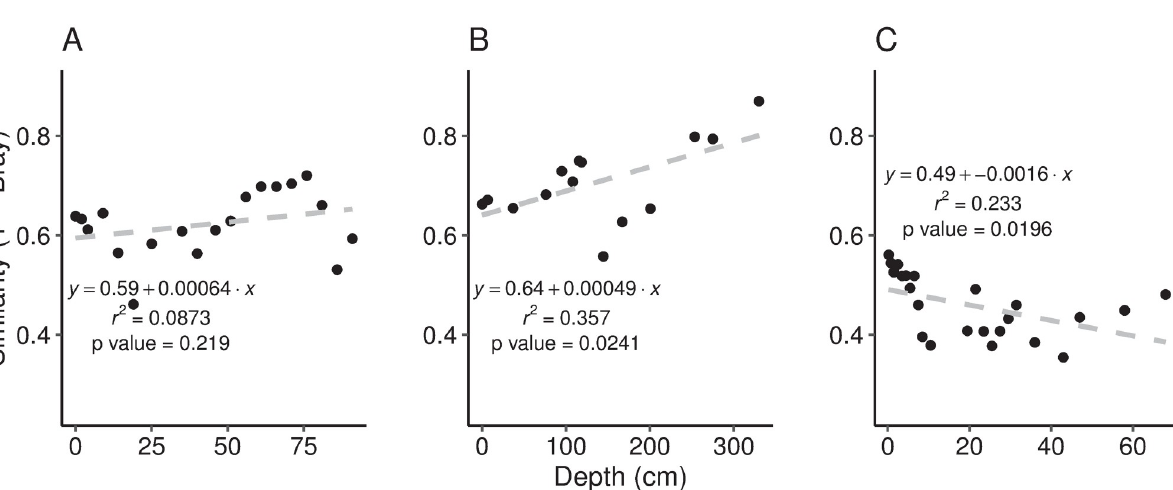
PLOS ONE | https://doi.org/10.1371/journal.pone.0250783 May 3,